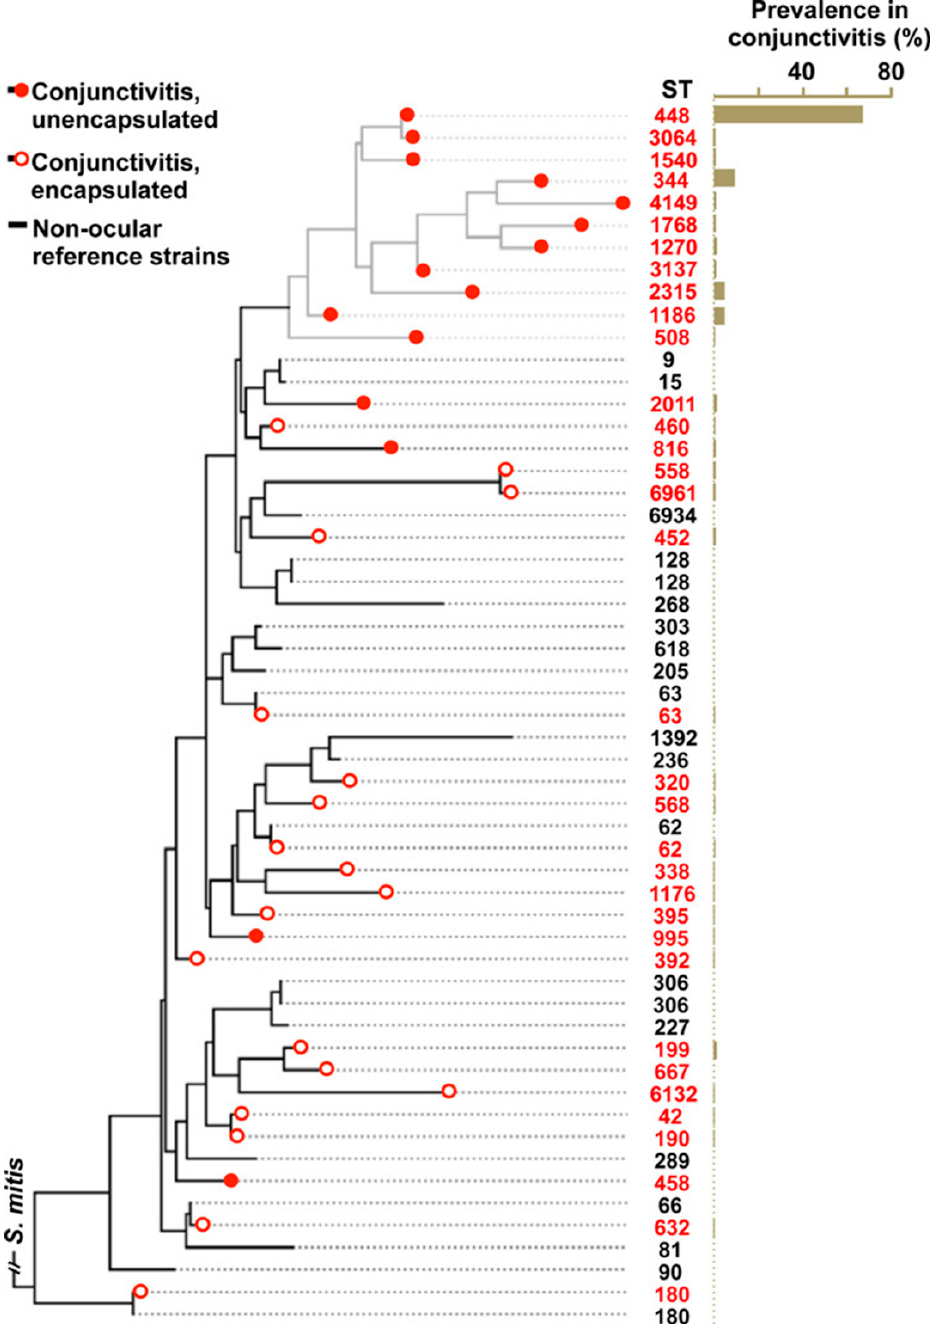
Figure 2. Phylogenetic tree of conjunctivitis strains of S. pneumoniae based on multilocus sequence typing, constructed using the phylogeny software PhyML [115]. An associated bar graph demonstrates the percentage prevalence in 271 sequenced strains from the US. The analysis of single nucleotide polymorphisms within these strains demonstrated that the overwhelming majority of nonencapsulated conjunctivitis strains localized to a distinct phylogenetic cluster. Reprinted with author permission [10].